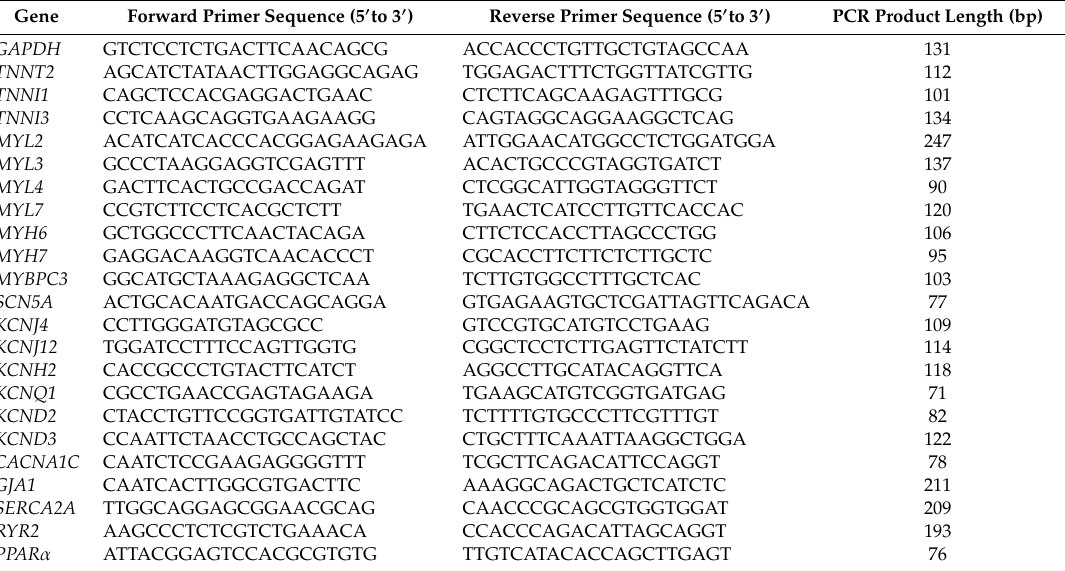
Table 2. Primer sequences for reverse transcription-quantitative polymerase chain reaction RT-qPCR). Gene Forward Primer Sequence (5 (cid:48) to 3 (cid:48)